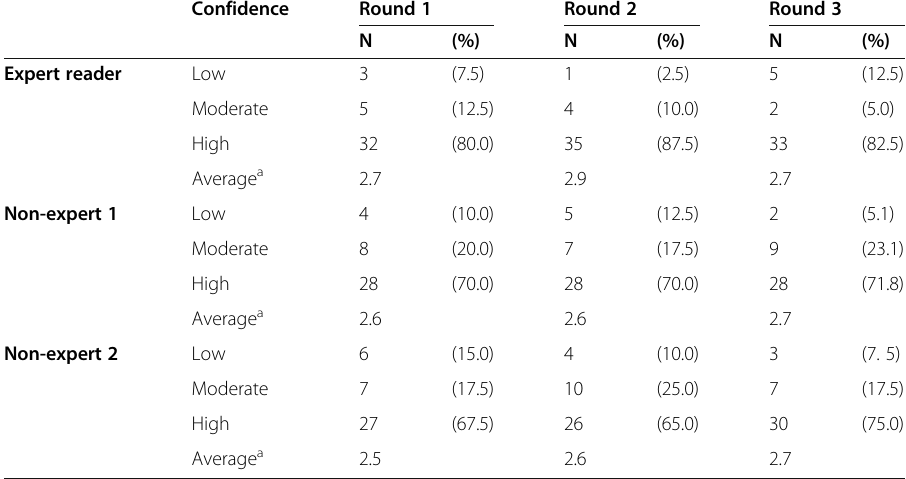
Table 2 Confidence scores by round and reader